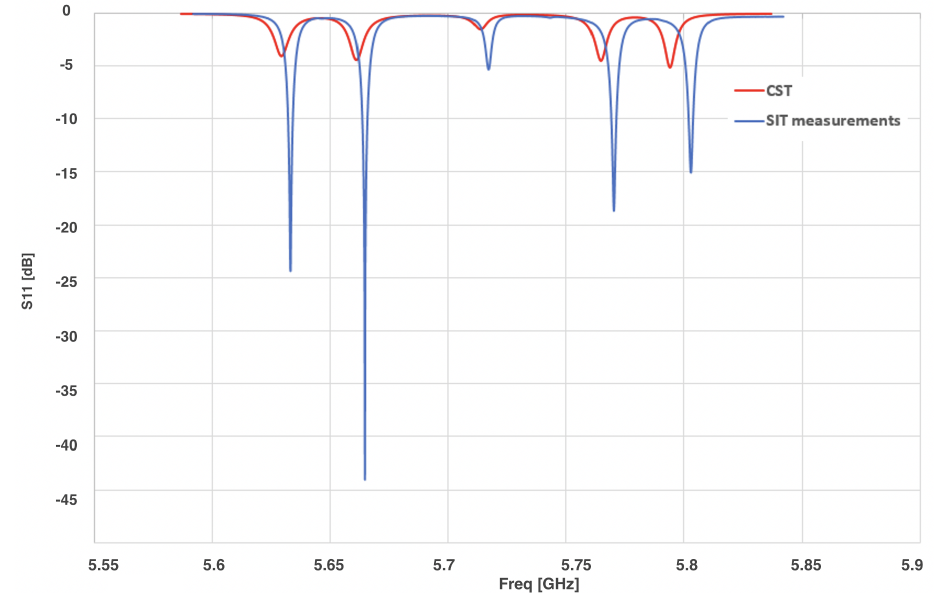
Figure 9. Comparison of the Reflection coefficient S11 in dB after tuning process (in blue) and from simulations (in red).